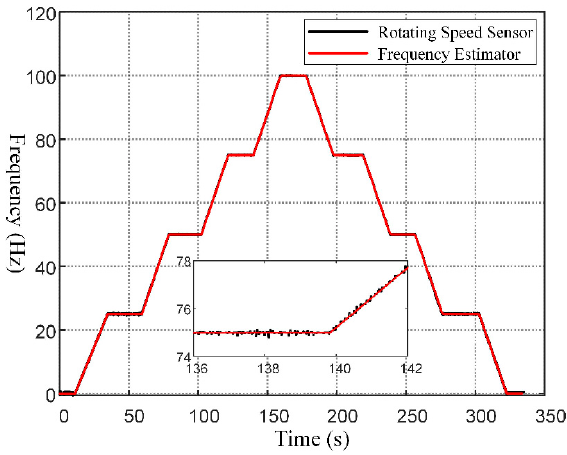
Figure 10. Experimental results of the frequency estimator.